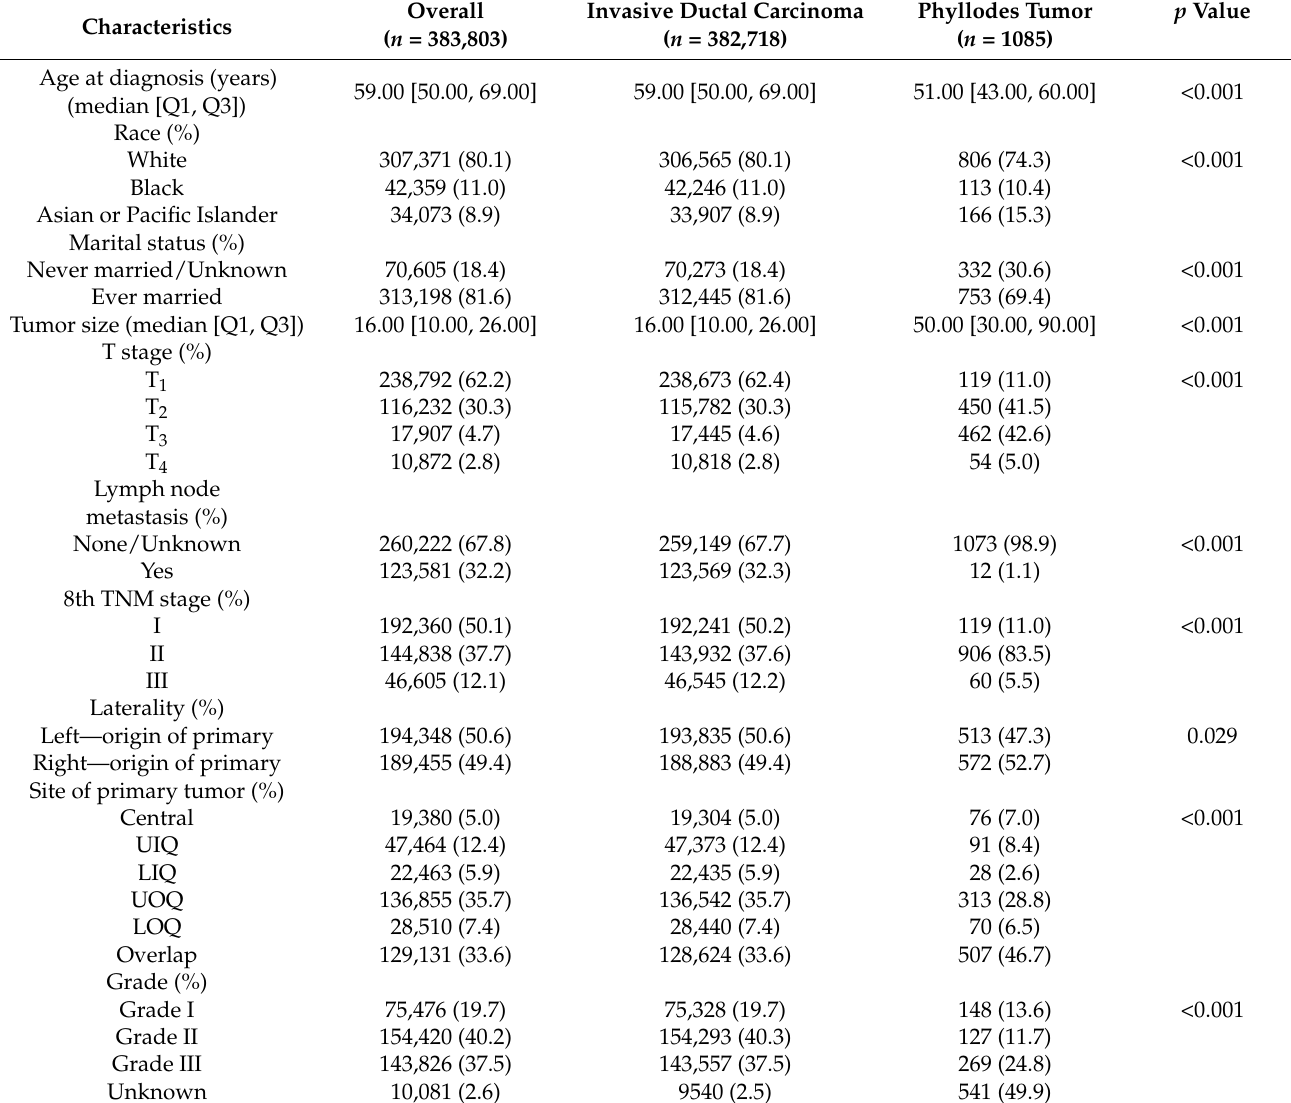
Table 1. Comparison of malignant invasive ductal carcinoma and malignant phyllodes tumor